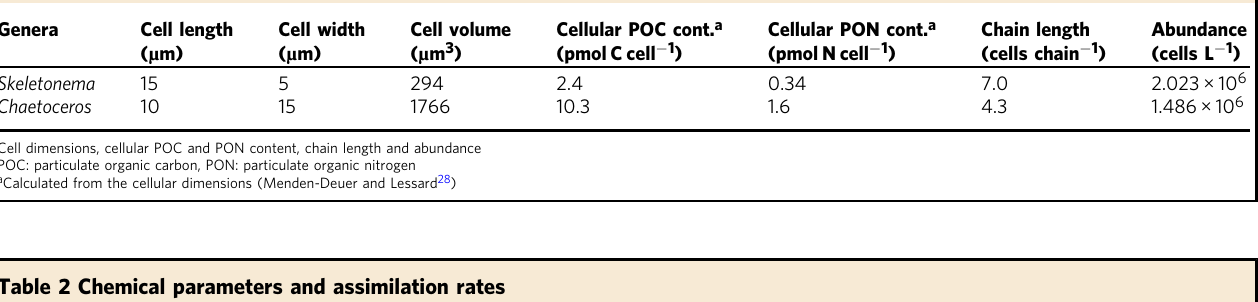
Table 2 Chemical parameters and assimilation rates Nitrite + Nitrate ( µ mol L − 1 )